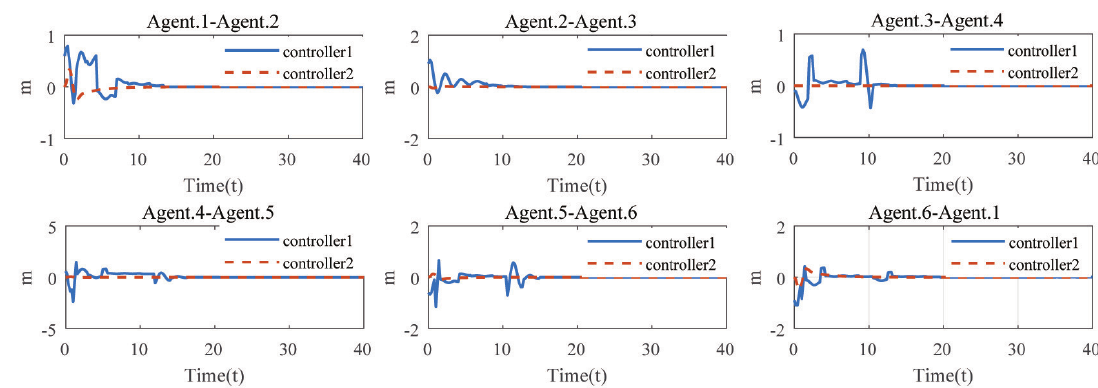
Figure 7. Synchronization errors on